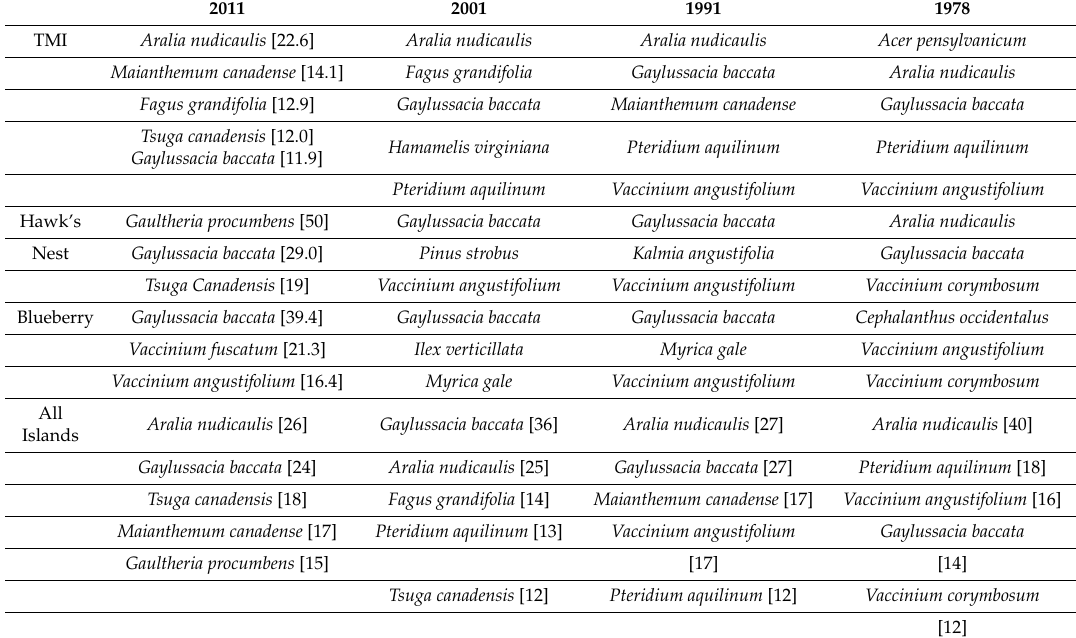
Table 2. Dominant Understory Species by importance values on TMI, HNI, and BI. These species are listed by decreasing importance value in [] for each island and sampling